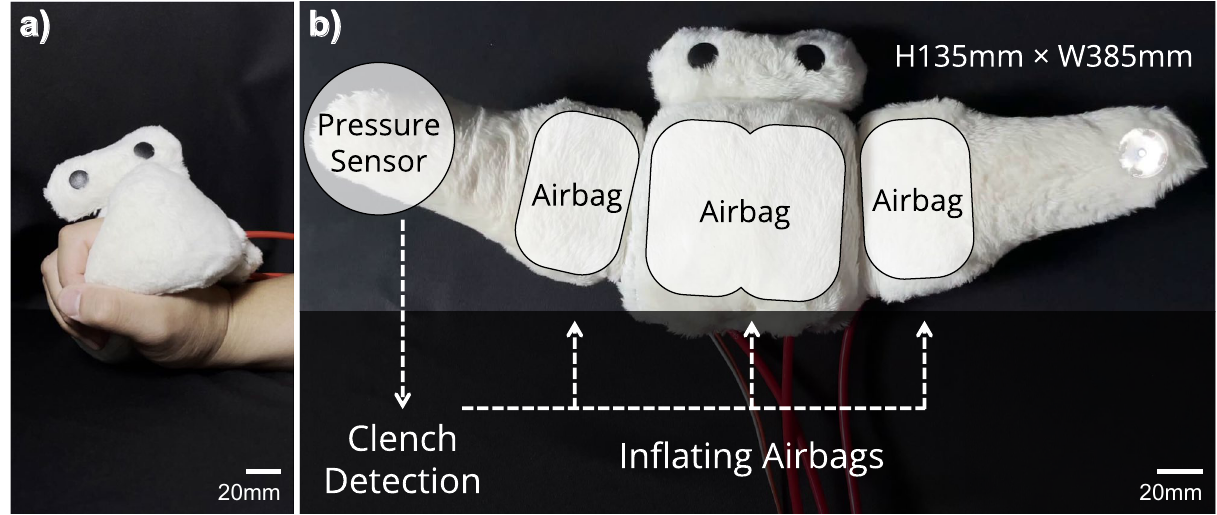
Figure 7. Inflatable hand-held soft robot. ( a ) The robot can be attached to the user’s hand. ( b ) Internal components were connected to an external pneumatic system with air